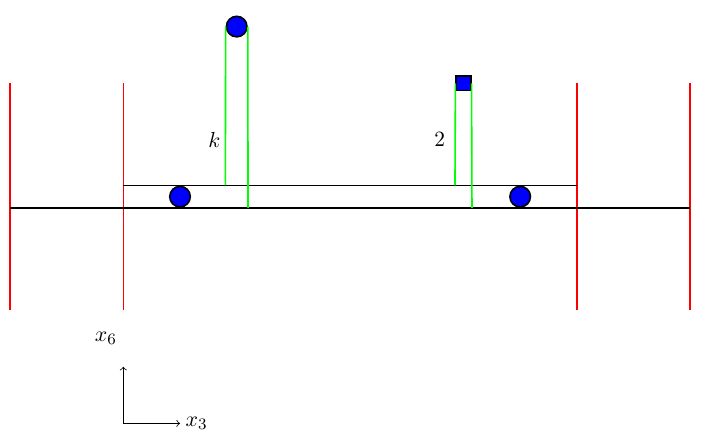
Figure 13 . Type IIB brane construction for a gauge vortex defect for U(2) in a representation R = S k ⊗ A 2 . The blue rectangular nodes denote NS5’-branes, while the green vertical lines denote